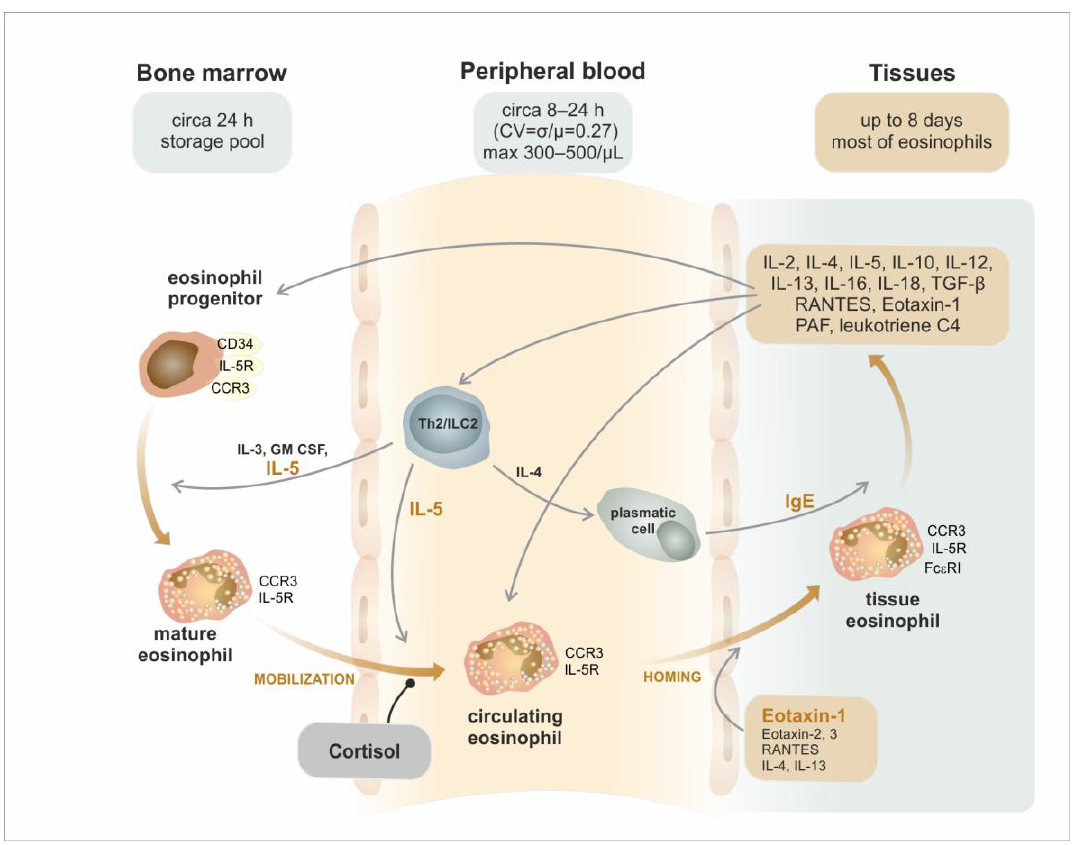
Figure 3. Eosinophil trafficking from the bone marrow to the periphery. After the maturation of eosinophils in the bone marrow, mature cells move into the peripheral blood. The half-life of eosinophils in the circulation is relatively short (approx. 8 – 24 h) with significant variability (Coefficient of Variation is 0.27), and the average count does not exceed 300 – 500 cells/ μL , depending on the endogenous production of cortisol. Then, the eosinophils settle in peripheral tissues in reaction to eosinophil adhesion (rolling, sticking, and emigration) induced by several cytokines and chemokines. Most of these cells survive and produce highly effective substances in the tissue environment and thus influence the close surroundings and further eosinophil production in the bone marrow as a back-loop.